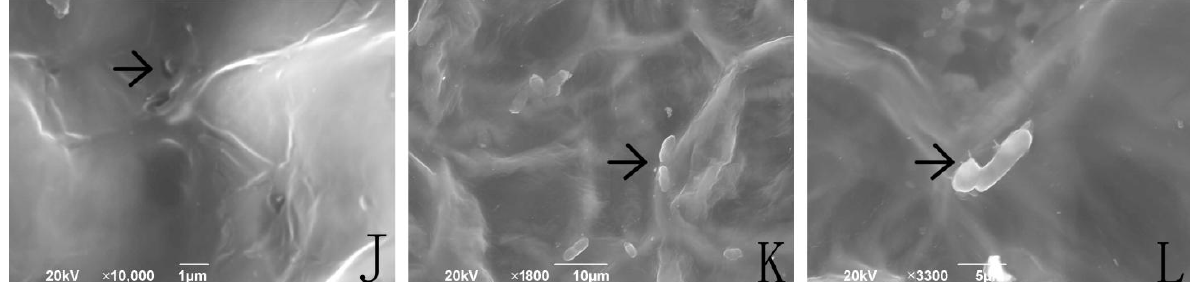
Figure 1. I. cateinannulata submerged conidia colonization of buckwheat leaf as assessed via scanning electron microscopy. Note: ( A ) Control group, no attachment or submerged conidial colonization were observed during the study period. ( B ) Submerged conidia (diameter ≤ 2 µ m) were attached to leaf surfaces after spraying. ( C ) Submerged conidia on leaf surfaces, at 0.5 h after inoculation, began to invade leaf tissues, with clear evidence of tissue dissolution surrounding spores, which were primarily at leaf veins and stomata. ( D ) A germ tube was oriented in place and had transferred its nucleus into the leaf. ( E , F ) At 1–2 h after inoculation, the dissolution area of leaf tissue surrounding submerged conidia increased significantly, and these conidia gradually deformed and shrunk. ( G – J ) At 2–4 h after inoculation, the dissolution area of tissue surrounding inoculated spores gradually decreased, and numbers of submerged conidia had fallen substantially. The majority of conidia had either entered into leaves or dissolved with pit-shaped dissolution circles at this time point. Leaf morphology was normal at 4–8 h after spraying, with no morphological differences between inoculated leaves and control leaves. ( K , L ) Leaf tissues after inoculation. Some conidia (diameter > 2 µ m) did not enter the leaves and formed no visible dissolution circles, instead growing to yield tentacle-like structures affixed to the blade surface (1 L). arrows: the condition of the I. cateinannulata submerged conidia and the buckwheat